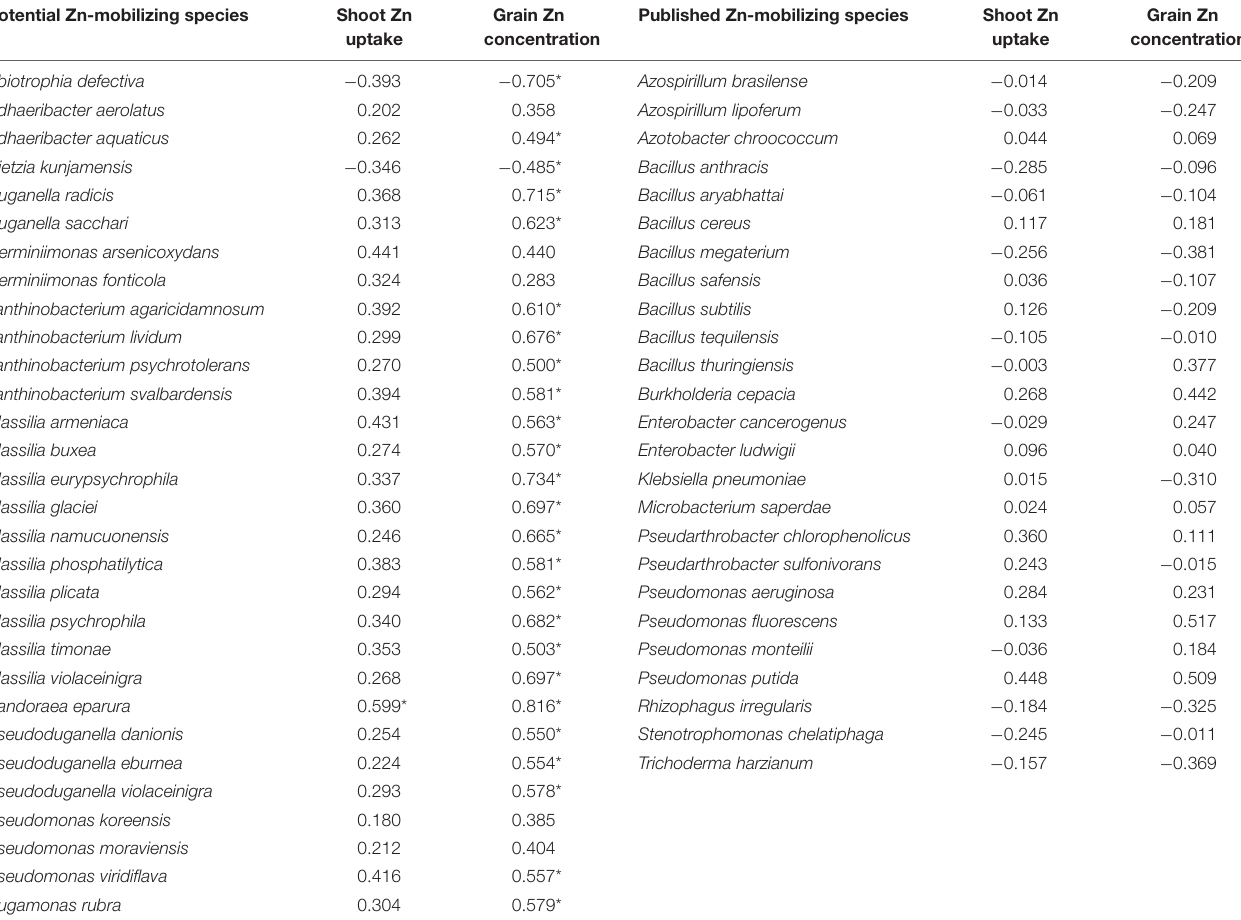
TABLE 3 | Spearman’s correlations between the relative abundances of soil Zn-mobilizing microbes and wheat grain Zn concentration and shoot Zn uptake at maturity. Potential Zn-mobilizing species Shoot Zn